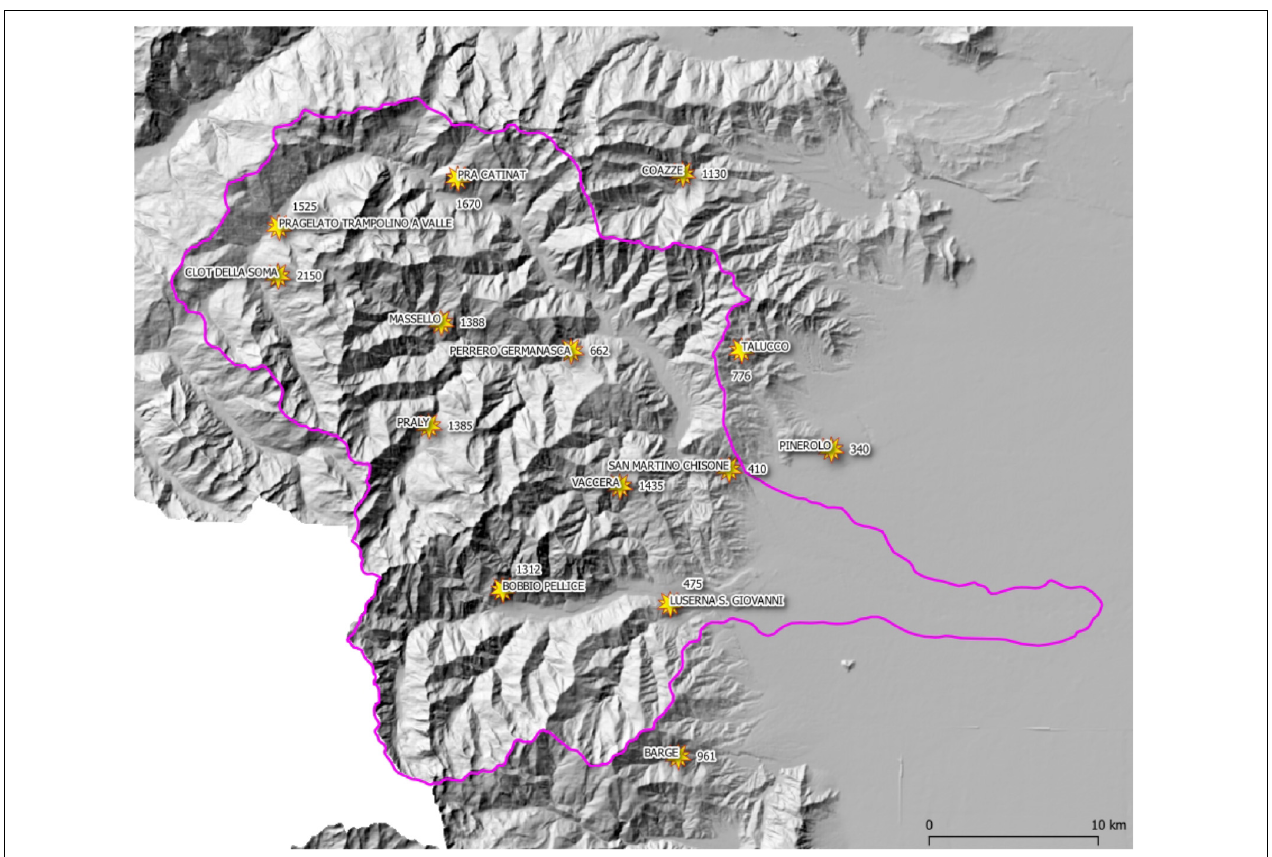
FIGURE 11 | Rain gages elevation distribution in Pellice-Chisone